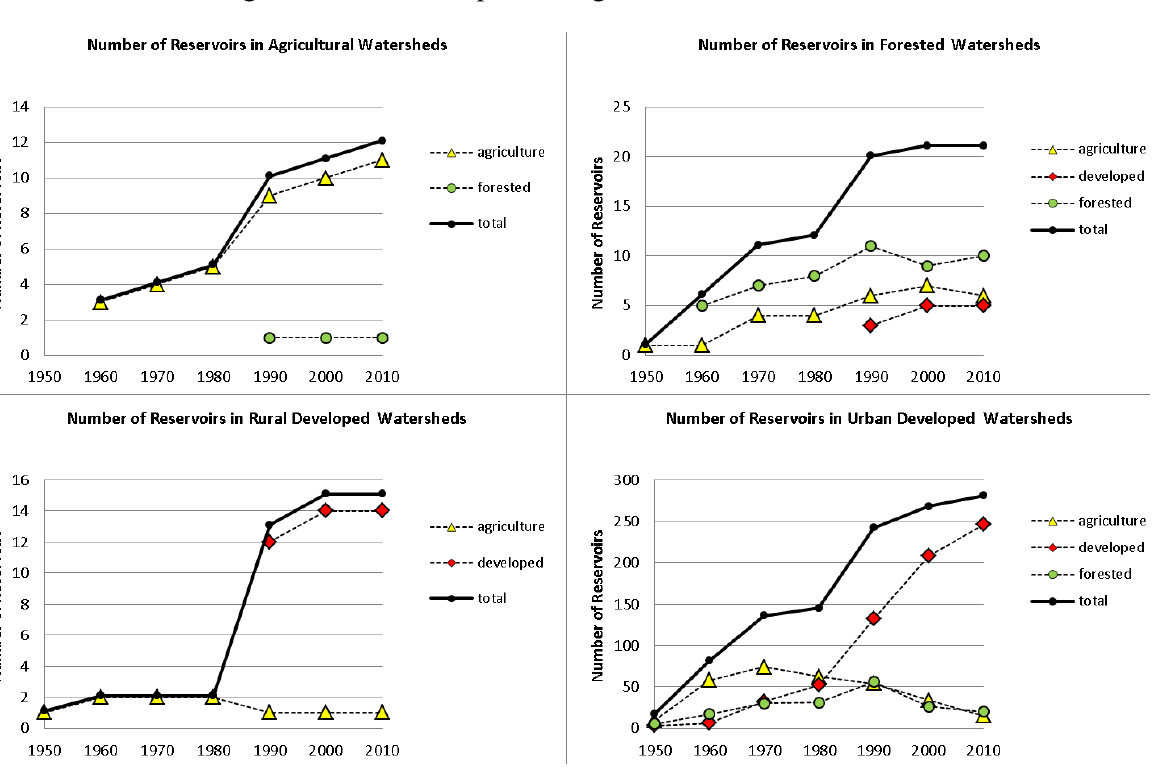
Figure 3. Number of small reservoirs from 1950 to 2010 as classified by adjacent land cover in watersheds categorized as agricultural, forested, rural developed, and urban developed based on the NLCD. The agricultural and forested watersheds remained dominated by reservoirs of those respective classes since 1960. However, in both the rural and urban developed watersheds, the dominant land cover adjacent to small reservoirs transitioned from agriculture to developed during the